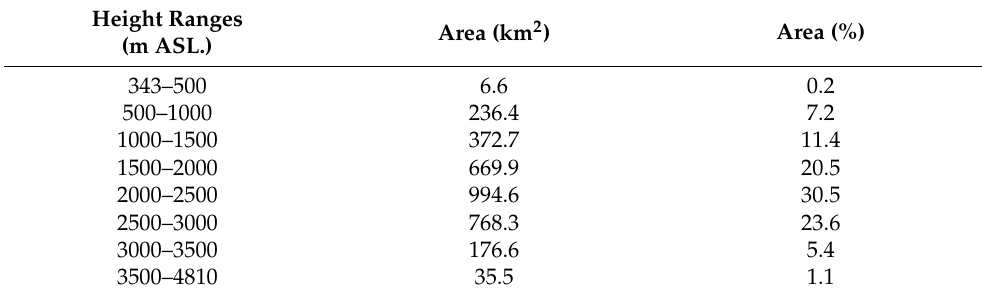
Figure 1. The study area corresponds to the whole Aosta Valley. It is located in the northwestern Alps of Italy, close to France and Switzerland. Source: Tommaso Orusa. Table 1. Aosta Valley height ranges and size of the corresponding areas. ASL: above sea level.